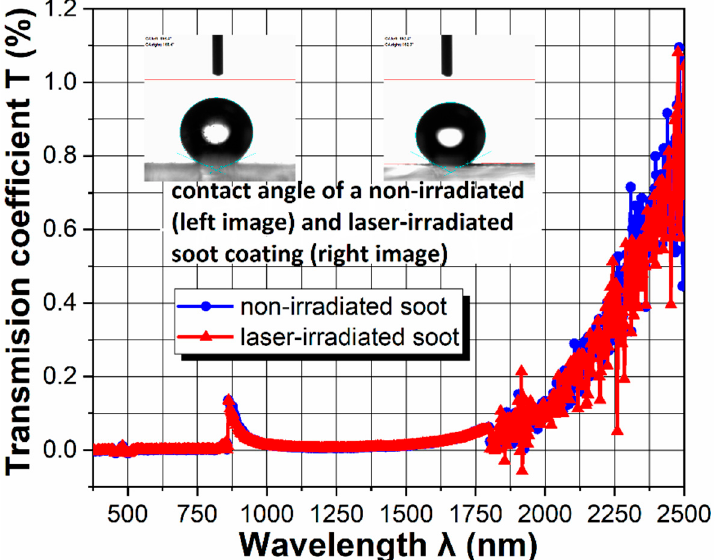
Figure 5. Light transmission spectra of the non-irradiated and laser-irradiated soot sample. The insets display the water contact angle before and after the laser treatment at p = 171 mW; t ir ~350 s.